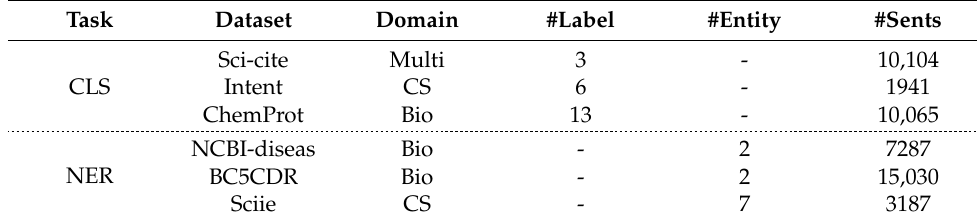
Table 1. Statistics of the